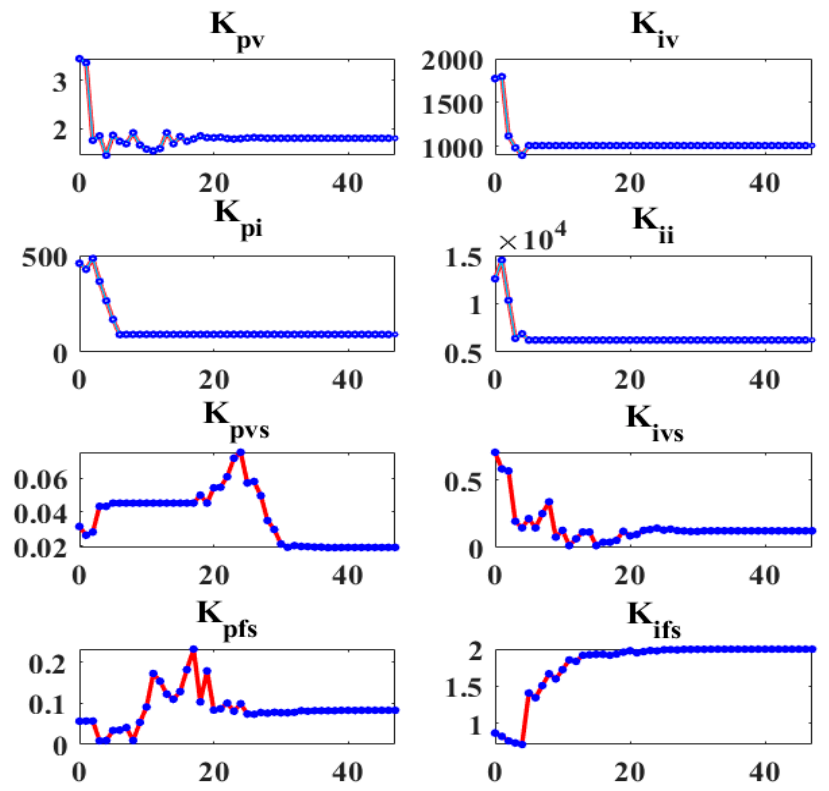
Figure 8. The GA-based optimum values of control parameters.